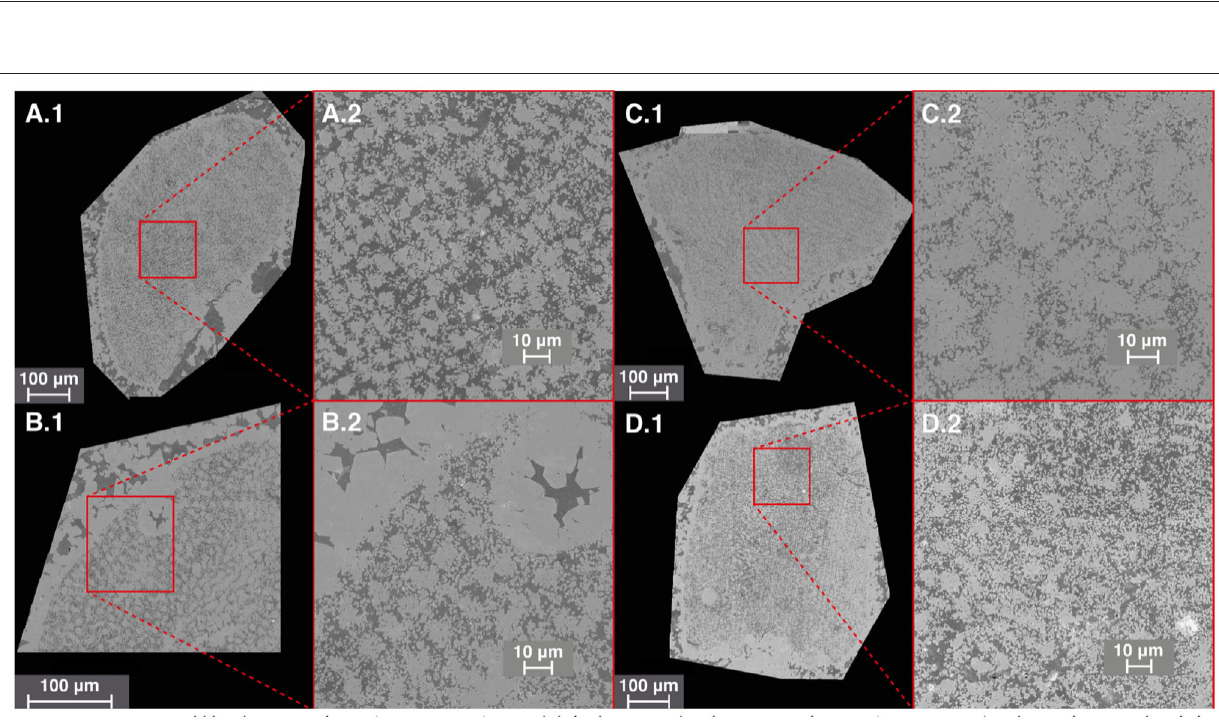
Frontiers in Water | www.frontiersin.org